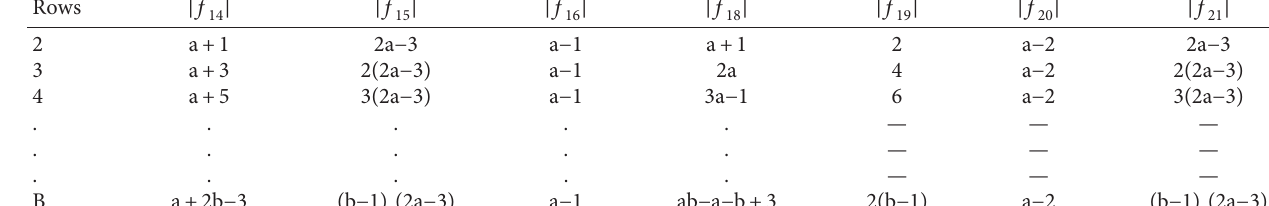
with given number of rows. 21